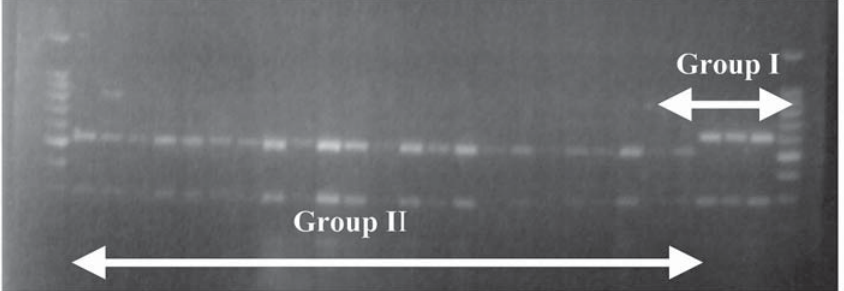
Fig. 4. Electrophoresis on 2% agarose gel showing the result of Bc-hch digestion with the Hha I restriction enzyme. Group I, 3 Botrytis pseudocinerea French isolates. Group II, a sample of 23 Tunisian